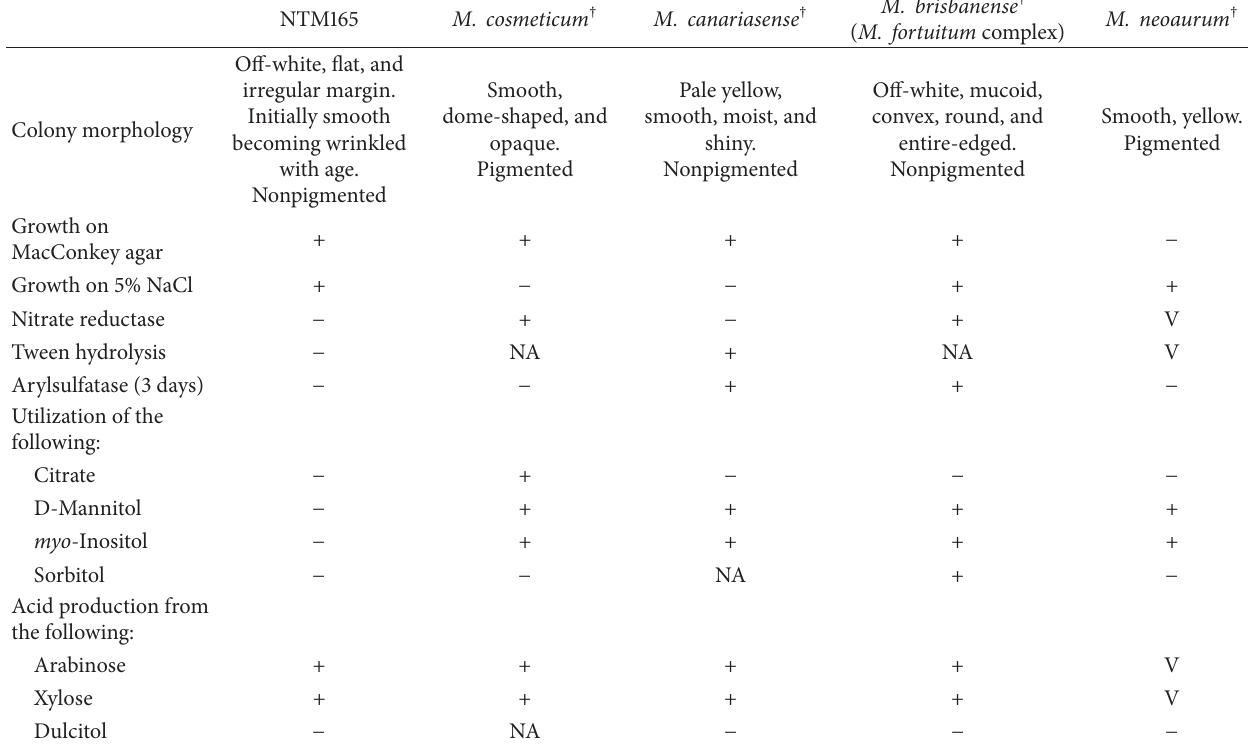
Table 1: Phenotypic characteristics of NTM165 and closely related rapidly growing mycobacteria.